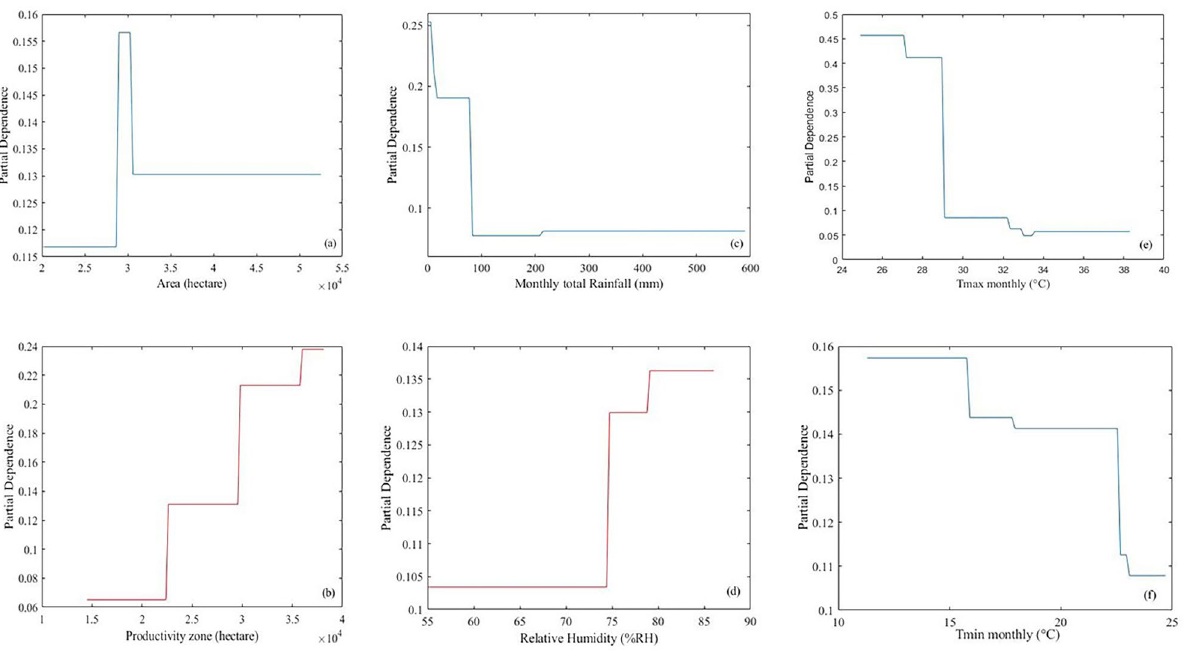
Figure 6. One-way PDPs of input variables on prediction of crop